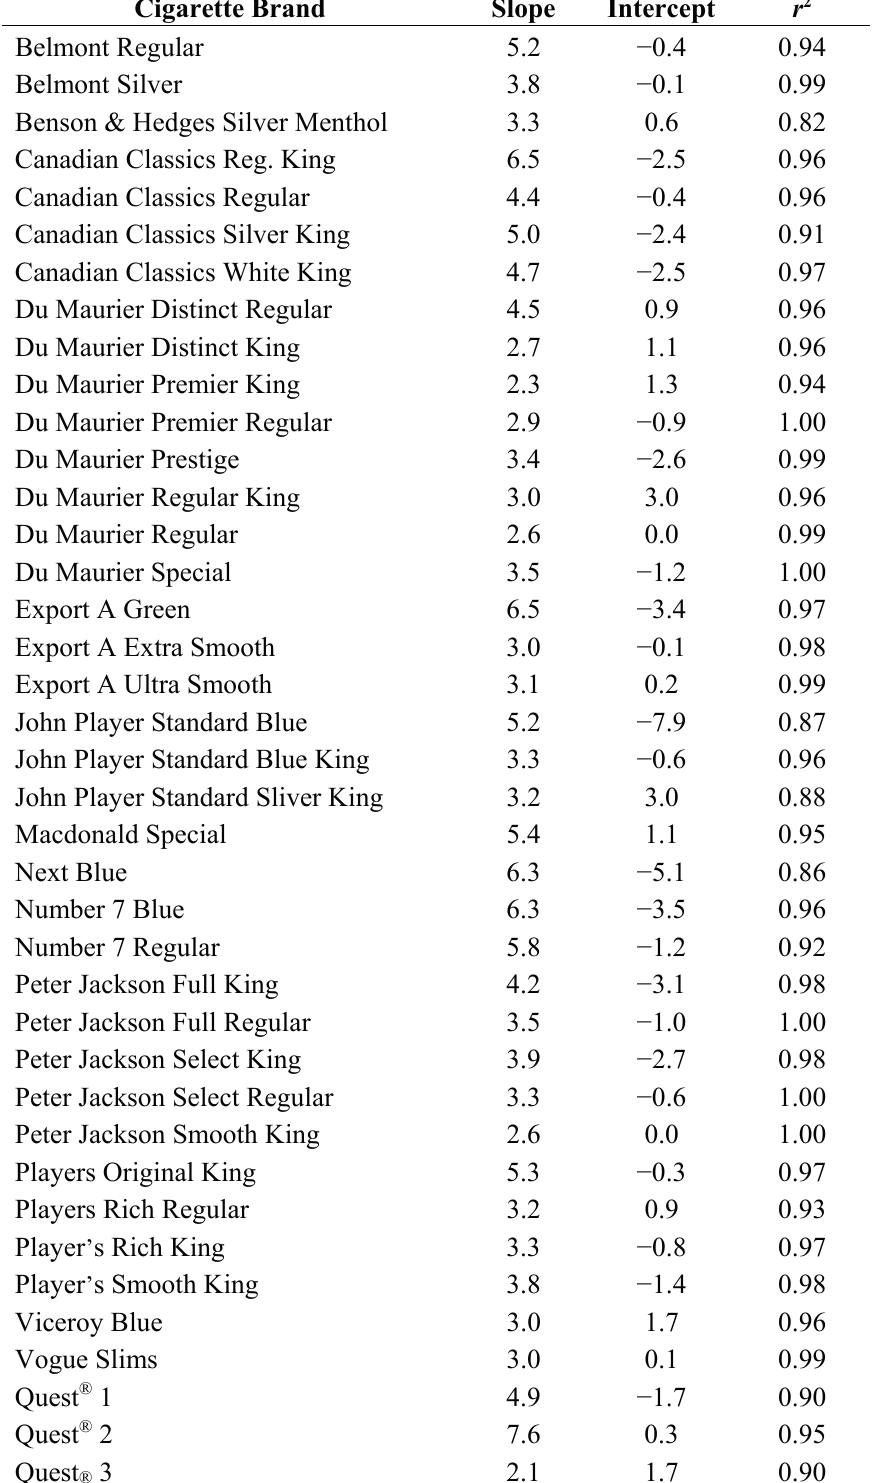
Table 4. Relations between BaP measured in mainstream smoke and spent filter butts. A correlation regression model for each brand was established using linear